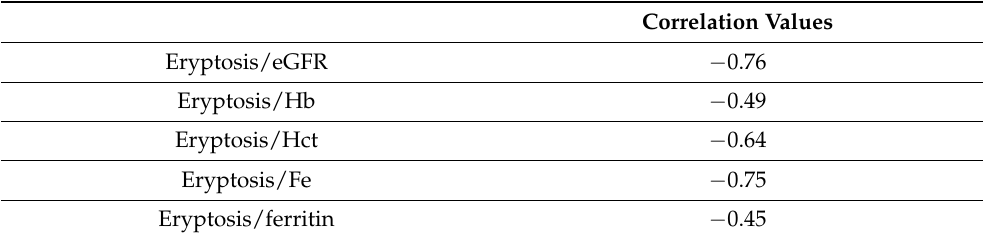
Table 3. Correlation between Eryptosis and eGFR, Hb, Hct, Fe and ferritin values (all, p <